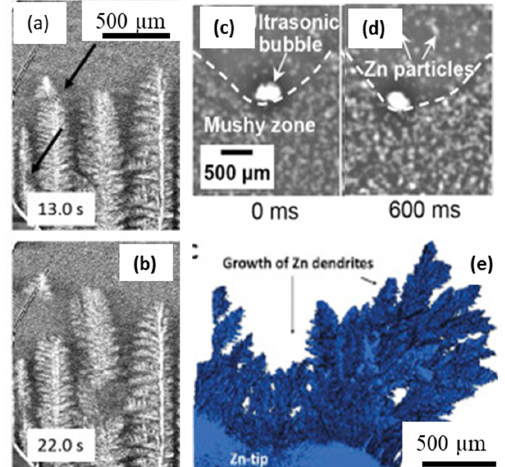
Figure 9. Solidification experiments in the presence of external forcing via electromagnetic and ultrasonic forcing, and electrochemical reactions: ( a , b ) solidification sequence of an Al–15 wt.% Cu alloy solidified with an electromagnetic field. Thermal gradient G = 48 K·mm −1 , peak current I = ±300 mA, pulse frequency 1 Hz, sine-wave form, magnetic field B = 0.1 T, and peak Lorentz force acting on the sample = ±0.3 mN (after Liotti et al.,[63]). ( c , d ) A sequence of X-ray images, showing the cyclic impact and pounding of the oscillating bubble at the L-S interface in the Bi-8% Zn alloy during ultrasonic cavitation, (after [139] ( e ) Reconstructed 3D cross-sectional image of the dendrites in zinc anode attached to the tip, (after Yufit et al., [140]). Permitted for reuse from respective publishers.